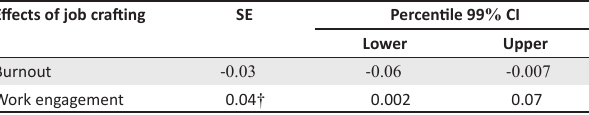
TABLE 6: Mediation of the effects of job crafting on burnout and work engagement through S-NS Fit and G-NS Fit. Effects of job crafting SE